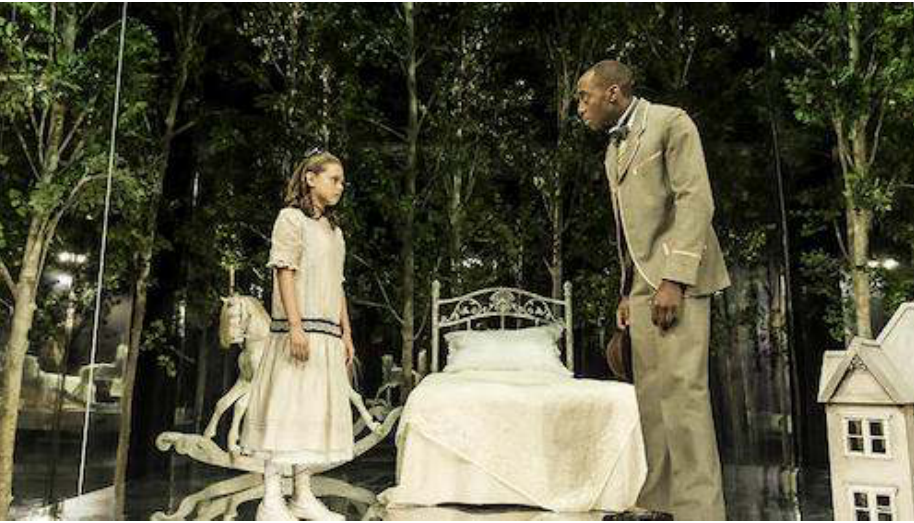
Figure 1. Jaime Adler as Iris and Ivanno Jeremiah as Woodnut in 2015 West End’s Duke of York’s Theatre production of Jennifer Haley’s The Nether